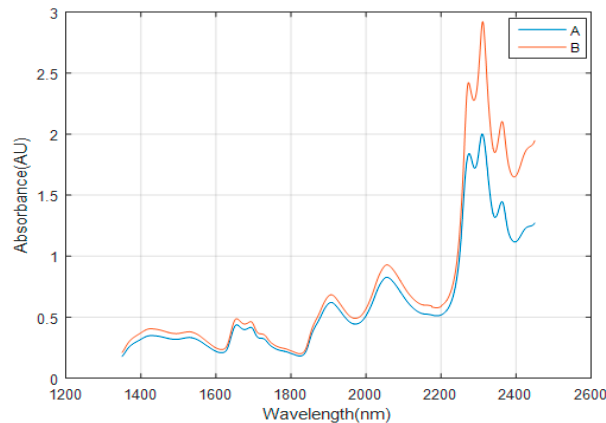
Figure 7. Absorbance spectrum of 95% ethanol. The blue line A is the absorbance curve of the test by the traditional scan method. The red line B is the absorbance curve of the test by the new scan